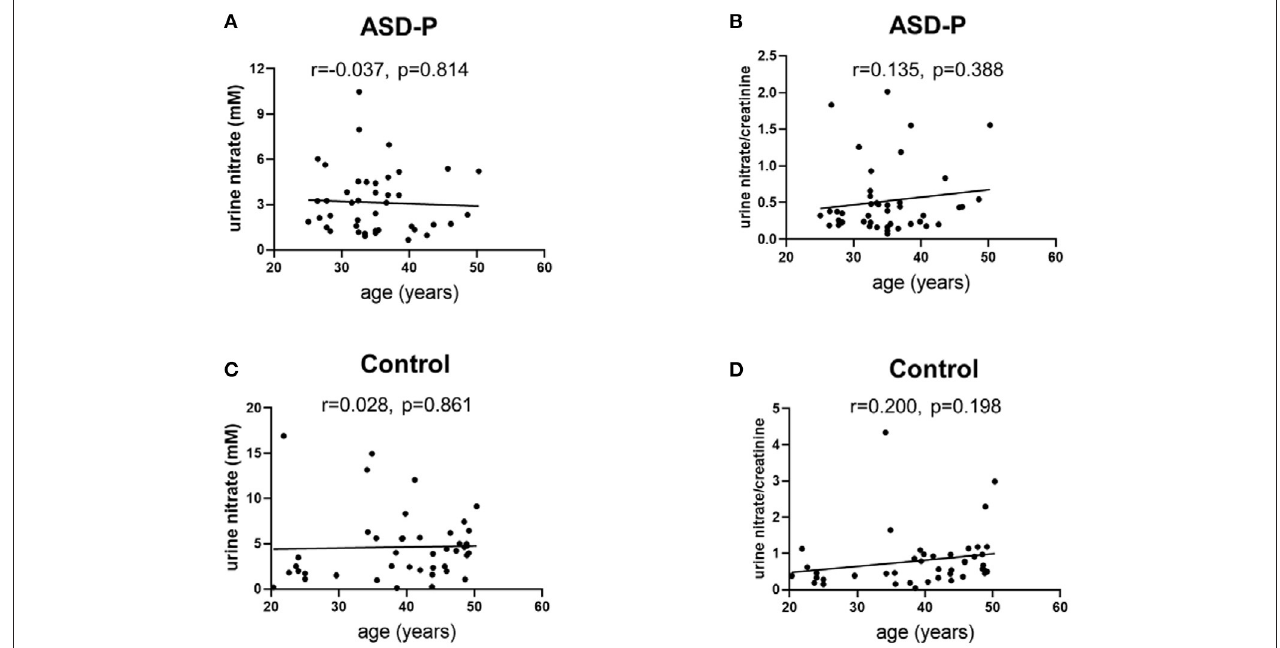
FIGURE 4 | Examination of urine nitrate and nitrate/creatinine vs. age. (A) urine nitrate and age in the ASD-P group, p = 0.814. (B) urine nitrate/creatinine and age in the ASD-P group, p = 0.388. (C) urine nitrate and age in the Control group, p = 0.861. (D) urine nitrate/creatinine and age in the Control group, p =